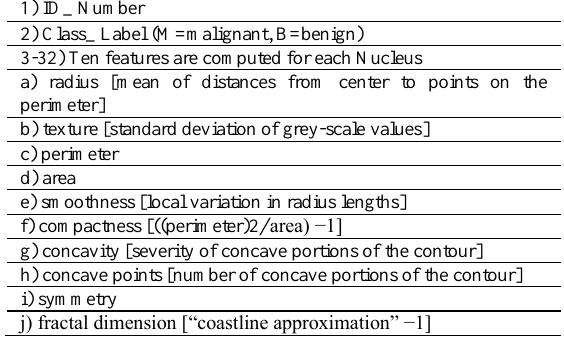
Table 1. WDBC cell nuclei characteristic attributes. 1) ID_